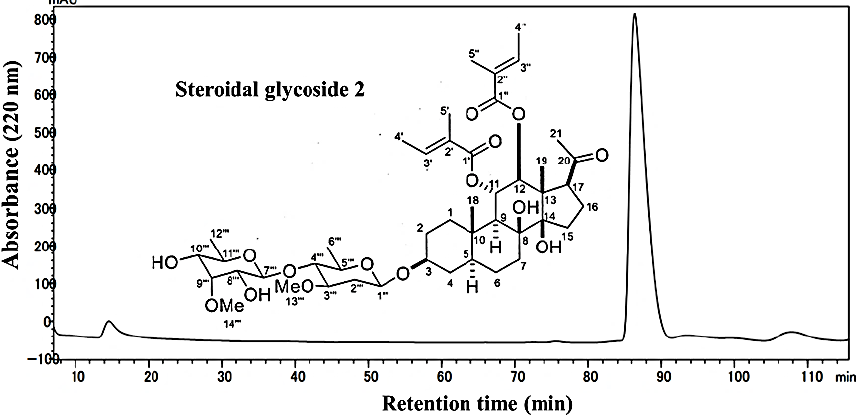
Figure 5. HPLC chromatogram and molecular structure of compound 2 .